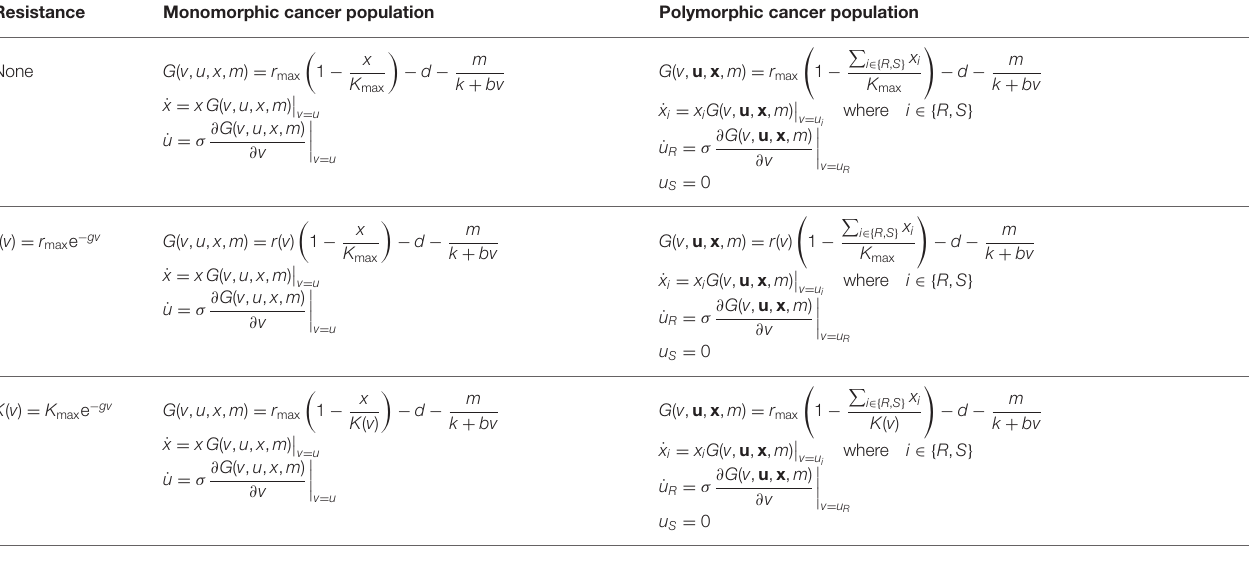
TABLE 2 | Variables and parameters of the model. Meaning